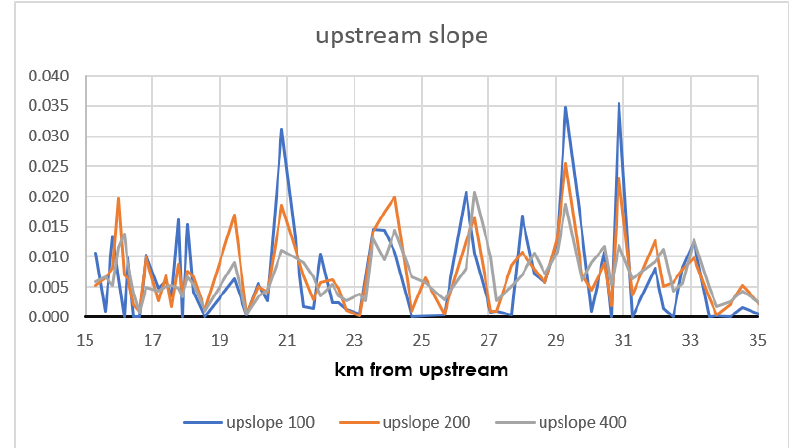
Figure 8. Plot of the upstream slope calculated using the three distances from the